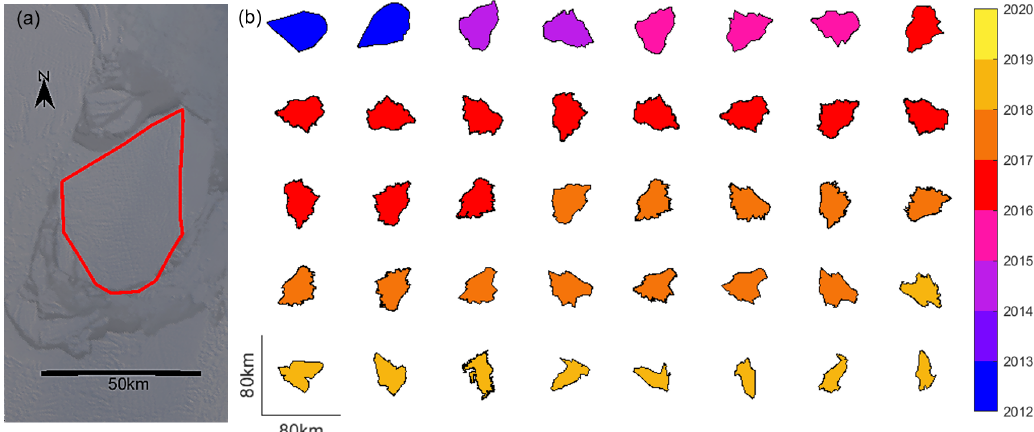
Figure 2. Outlines of the B30 iceberg derived from satellite imagery. (a) Initial shape (red polygon) of the B30 iceberg determined from MODIS images after calving; the background is a MODIS image on 11 September 2012. (b) Polygon outlines derived from further MODIS and Sentinel-1 imagery plotted in polar stereographic projection and used to calculate area change in the B30 iceberg.